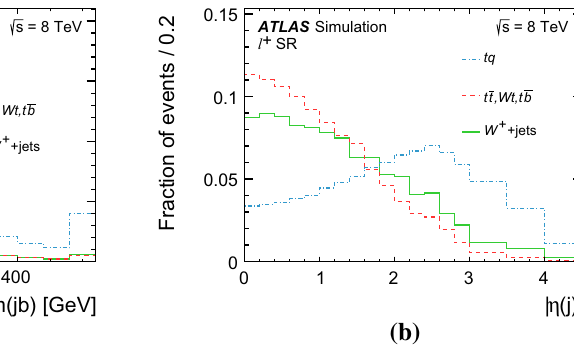
Fig. 3 Probability densities of the two most discriminating input vari- ables to the NN: a the invariant mass m ( jb ) of the untagged jet and the b -tagged jet, and b the absolute value of the pseudorapidity of the